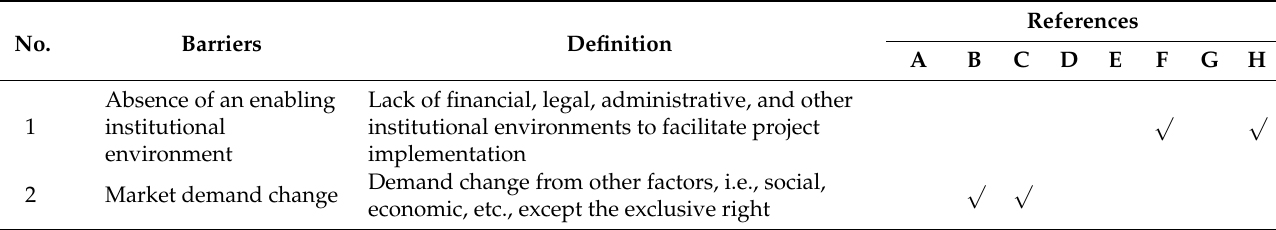
Table 1. Original barriers from the